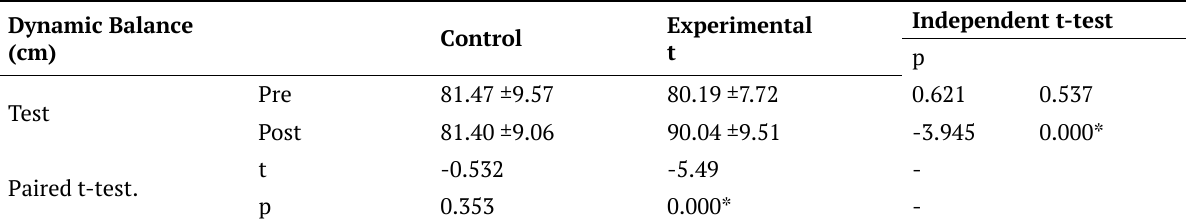
Table 2. The improvement of 12 sessions exercise programs on dynamic balance (Y-balance) of subjects in experimental and control